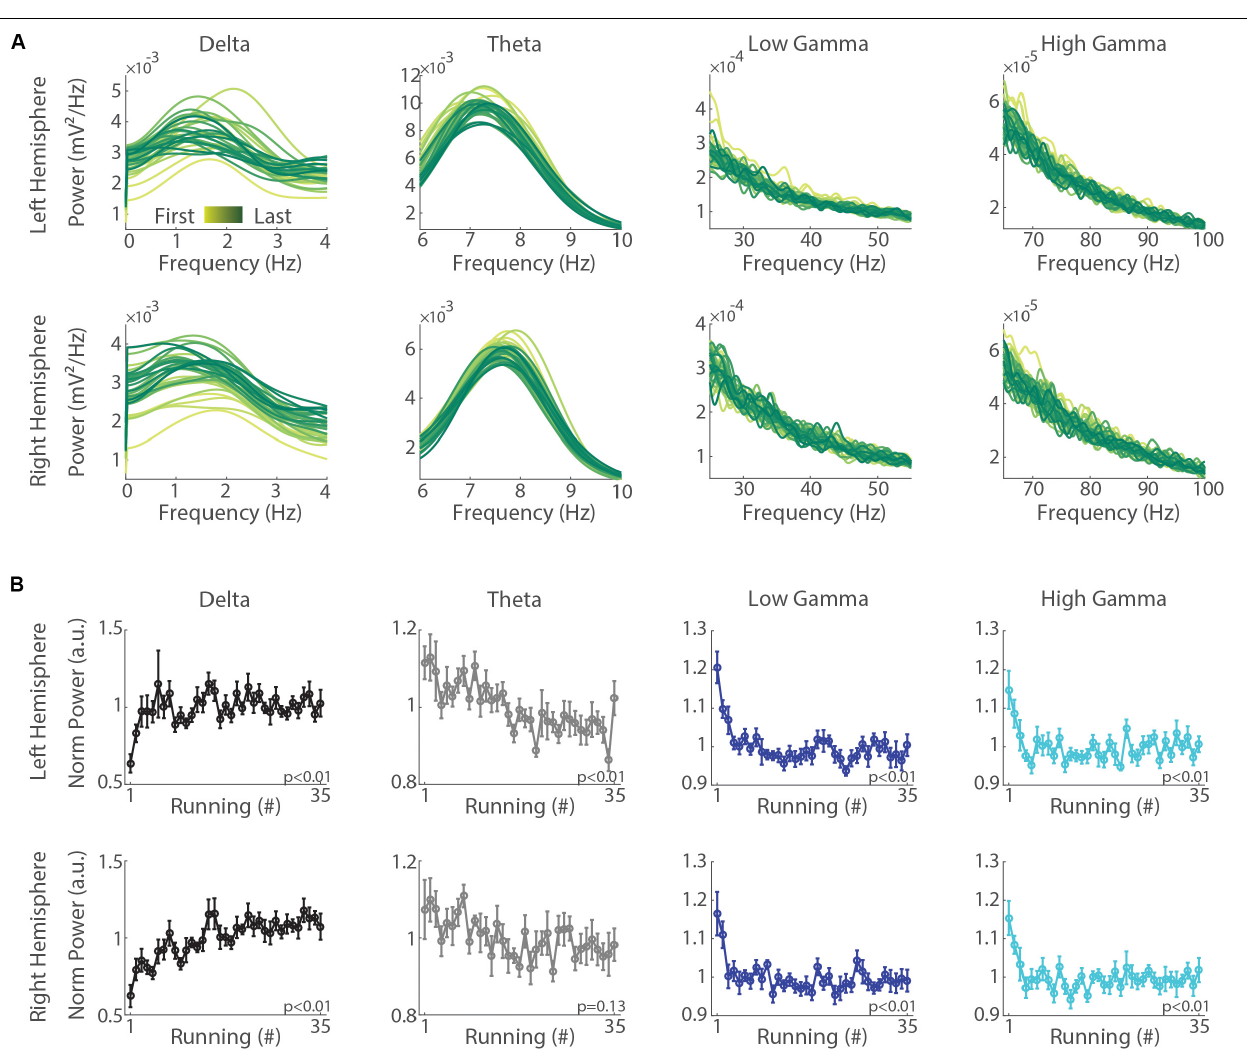
FIGURE 3 | Consecutive treadmill runs specifically increase delta band power while decreasing the power in theta, low gamma and high gamma oscillations. (A) Mean power spectra across the 35 runs in the left (upper panels) and right (lower panels) hemispheres. Notice a gradual increase in delta band power concomitantly with a decrease in the power other bands from the first to the last running (yellow to green shades, respectively). (B) Normalized mean power of delta, theta, low gamma and high gamma oscillations along the successive execution of 35 runs in the left (upper panels) and right (lower panels) hemispheres. Circles represent means and error bars represent ± SEM ( n = 11 sessions from three animals). The normalization was performed for each session by dividing power values on each running by the average across runs. Notice the significant increase of delta band power ( p < 0.01, repeated measures ANOVA) along with significant decreases in the power of theta, low gamma and high gamma bands in both hemispheres ( p < 0.01), except theta in the right hemisphere ( p =